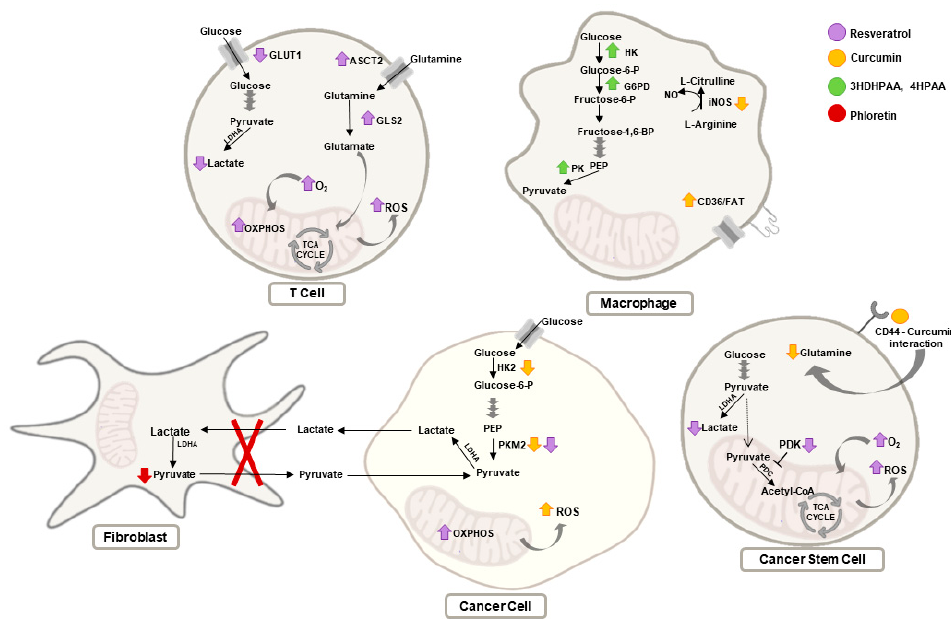
Figure 2. Overview of the main effects of the selected natural compounds on the metabolism of cells present in the TME, namely T cells, macrophages, cancer, and cancer stem cells, as well as on the disruption of the crosstalk between fibroblasts and cancer cells. Metabolic alterations induced by resveratrol are represented in purple, by curcumin in yellow, by the flavonoid derivatives 3,4DHPAA and 4HPAA in green, and by phloretin in red. Abbreviations: 3,4DHPAA, 3,4-dihydroxyphenylacetic acid; 4HPAA, 4-hydroxyphenylacetic acid; Acetyl-CoA, acetyl-coenzyme A; ASCT2, alanine-serine-cysteine transporter 2; FAT, fatty acid transporter; Fructose-1,6-BP, fructose 1,6-bisphosphate; Fructose-6-P, fructose-6-phosphate; G6PD, glucose-6-phosphate dehydrogenase; GLS2, glutaminase 2; Glucose-6-P, glucose-6-phosphate; GLUT1, glucose transporter 1; HK, hexokinase; LDHA, lactate dehydrogenase A; PDK, pyruvate dehydrogenase kinase; PEP, phosphoenolpyruvate; PHD, pyruvate dehydrogenase complex; PK, pyruvate kinase; ROS, reactive oxygen species; TCA cycle, tricarboxylic acid cycle.